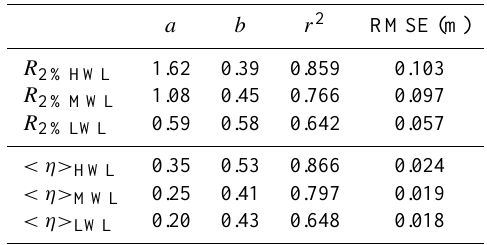
Table 3. Hyperbolic tangent fit to R 2% values, R 2% = a tanh (bH 0 ) , and < η > values corresponding to high water level (HWL), mean water level (MWL), and low water level (LWL). Correlation ( r 2 ) and root mean square error (RMSE) in